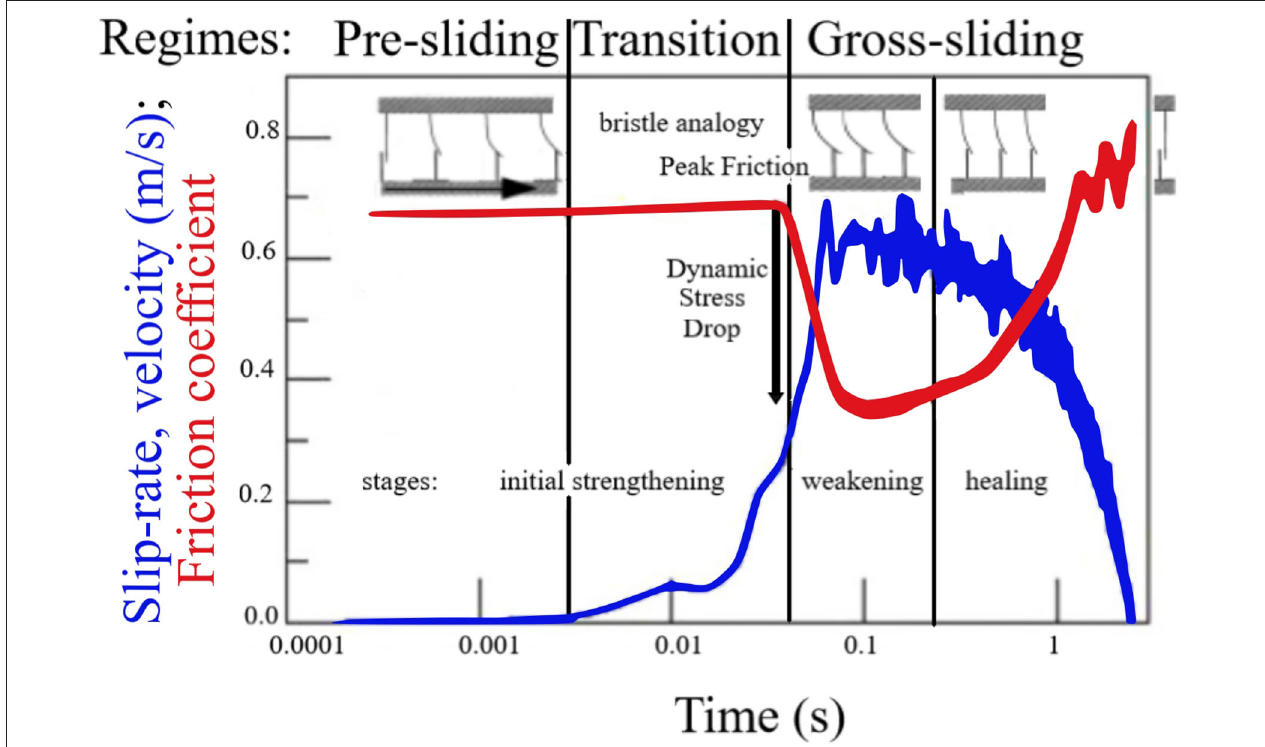
FIGURE 1 | Conceptual cartoon describing the bristle analogy for internal state variable evolution and different sliding regimes as applied to a conception of earthquake rupture process. Fault frictional evolution stages (initial strengthening, weakening, and healing) are labeled within the figure, while the corresponding sliding regimes are organized on top. Motivated by Figure 2E of Liao and Reches (2019), frictional data from a spinning flywheel impact experiment on a Sierra White granite sample [run 733 from Chang et al. (2012)]. The logarithmic time scale (x axis) enhances the evolution at early times and the initial strengthening stage, it also makes the initial acceleration look less dramatic in comparison to the deceleration. Motivating data are plotted with a linear time scale with inversions in the Supplement